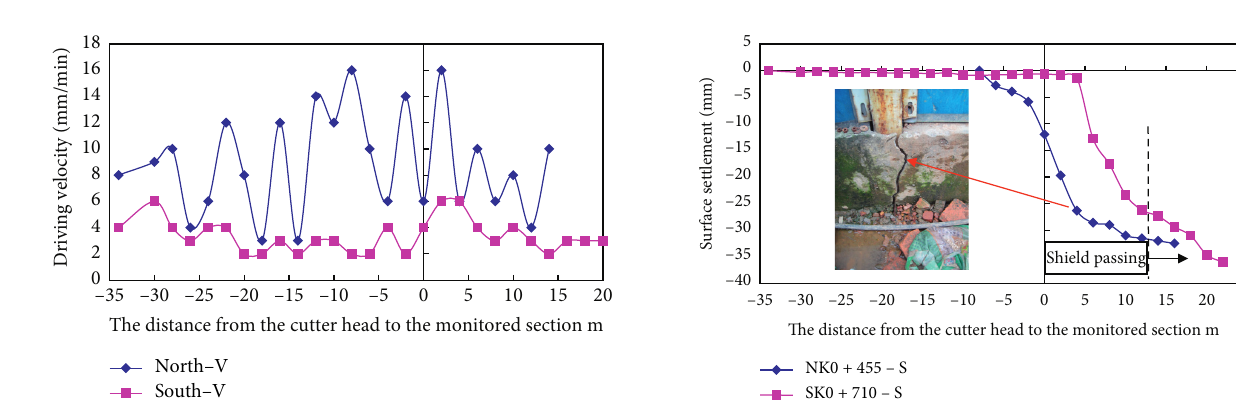
Figure 9: Settlement curves and cracks in the